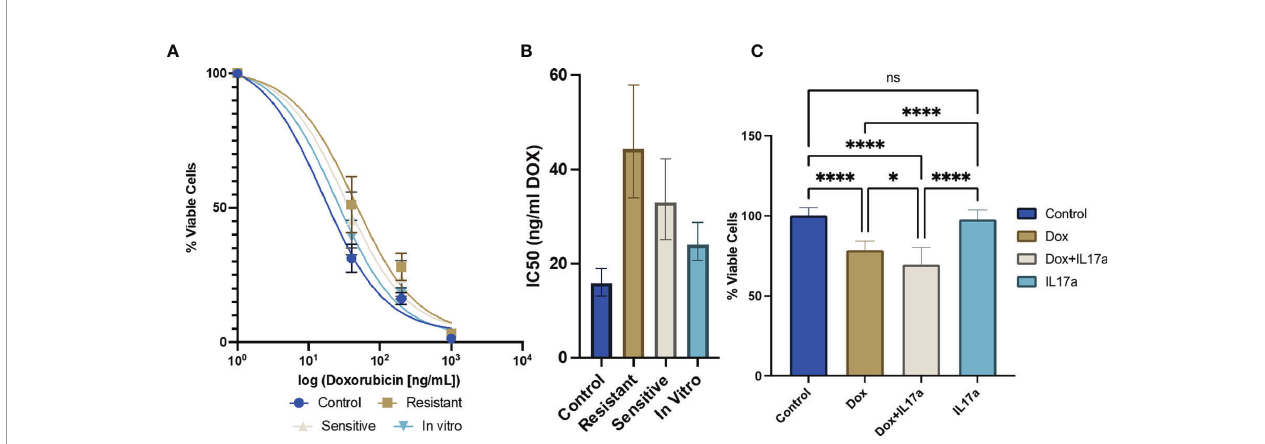
FIGURE 6 | IL-17A co-administration with DOX directly affects chemotherapeutic ef fi cacy in cancer cells. (A) Ex vivo DOX sensitivity from 4T1-Thy1.1 cells isolated from primary tumors or from in vitro culture (n=12 from 3 independent tumors). (B) IC50 values extrapolated from dose response curves with error bars represent 95% CI. (C) Relative viability of 4T1-Thy1.1 cells cultured in the presence of DOX and/or IL-17A for 48 hours (n=9-11). ns: non-signi fi cant p > 0.05; * p ≤ 0.05; **** p ≤